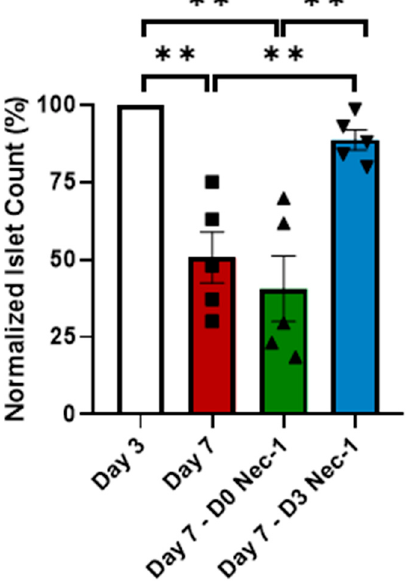
Figure 1. Islet recovery on day 7 of tissue culture in control media or media supplemented with Nec-1 either immediately after islet isolation (D0 Nec-1) or on day 3 of tissue culture (D3 Nec-1). Islet recovery was calculated as the percentage of IEQ per gram of pancreatic tissue normalized to day 3 of control untreated islets. n = 5 for each group. ** p < 0.01. Individual data points for islets cultured in control media (Day 7) or media supplemented with Nec-1 either immediately after islet isolation (D0 Nec-1) or on day 3 of tissue culture (D3 Nec-1) are shown within each bar graph as either squares, triangles, or inverted triangles, respectively. Data expressed as mean ± SEM.